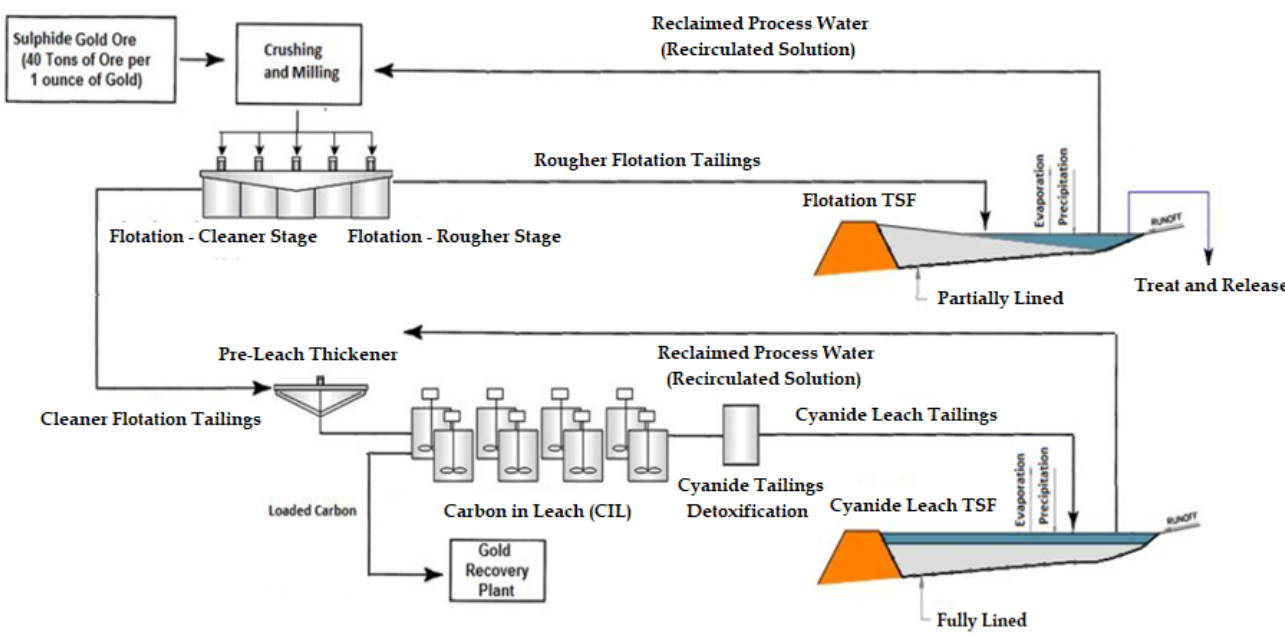
Figure 3. Typical sulphide gold ore flowsheet process—gold mine tailings management [4]. Additionally, cyanide-leach TSFs are typically fully lined: a GCL-geotextile–geomembrane liner is placed at the upstream face of the dam and impoundment to prevent seepage through the im-